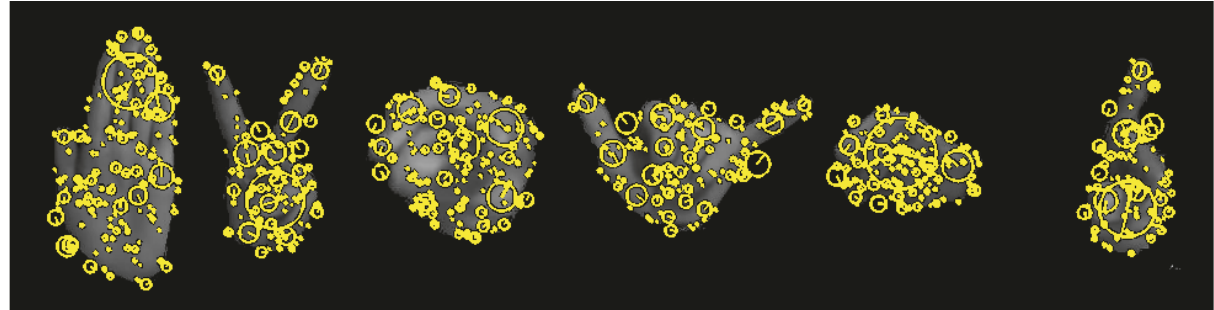
Figure 23: Feature points detected on six postures by SIFT, from left to right of the postures, are “Palm,” “V,” “Point,” “Y,” “Fist,” and